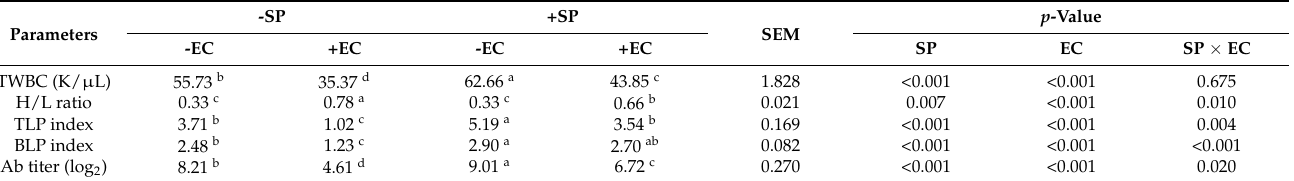
Table 5. Effect of dietary Spirulina platensisis (SP) supplementation on the immunological parameters of broilers challenged by Escherichia coli (EC)